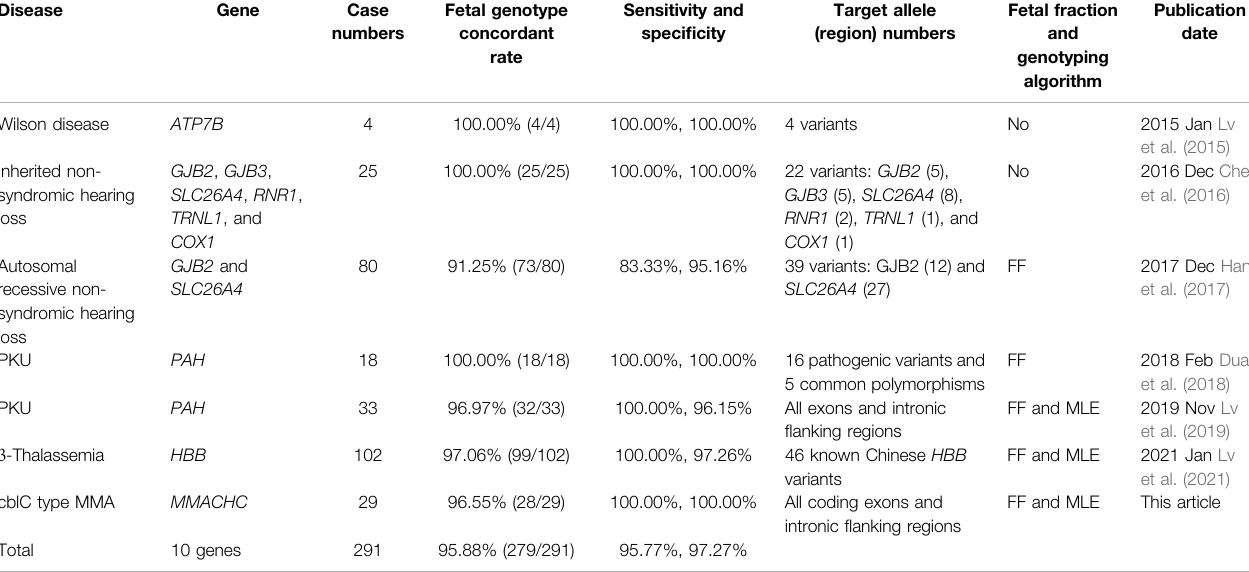
TABLE 2 | A summary of the published cSMART applications of NIPT for different monogenic disorders.